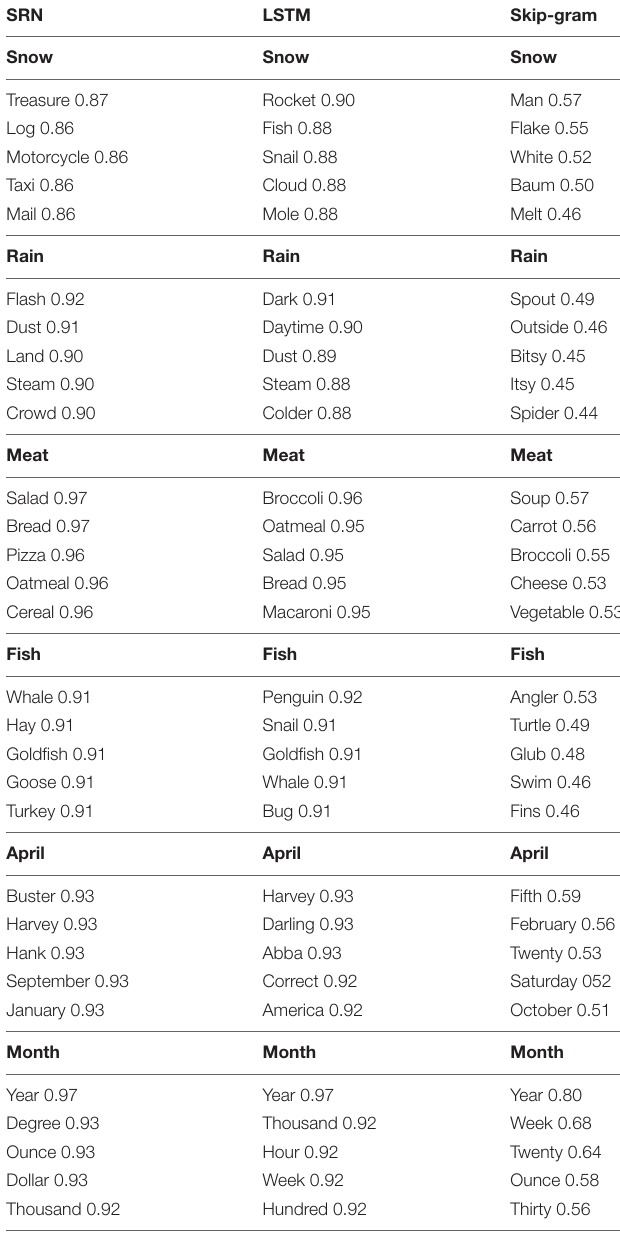
TABLE 4 | Nearest semantic neighbors from SRN, LSTM, and Skip-gram for two words in the categories ‘weather,’ ‘meat,’ and ‘months.’ SRN LSTM